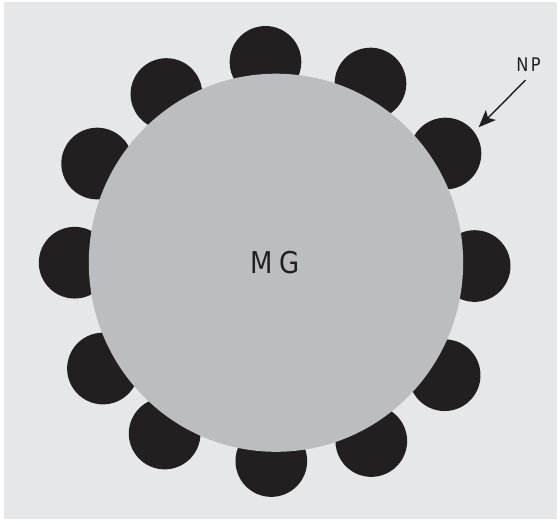
Schematic of the “polymer core/nanoparticles shell” com- posite